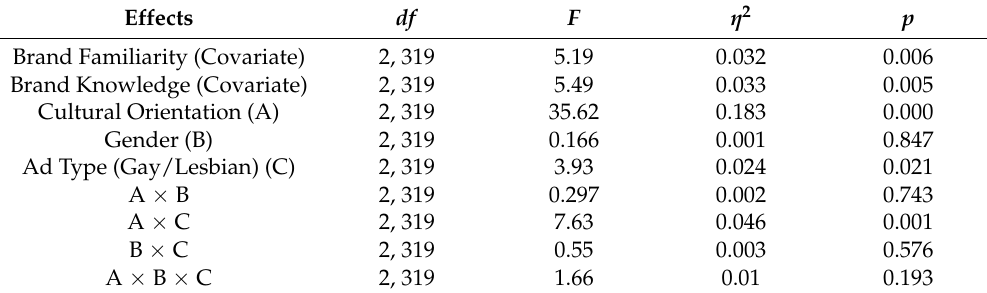
Table 2. MANCOVA Results: Effects of Cultural Orientation, Gender, and Ad Types.